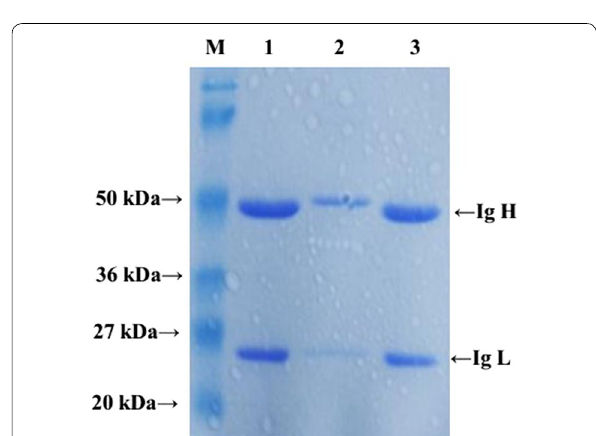
Fig. 2 SDS-PAGE analysis for ascites. Bands of 50 kDa and 25 kDa were identified as heavy and light chains. Lane M, protein molecular weight marker; lane 1, mouse ascites of 1D6; lane 2, mouse ascites of 2G6; lane 3, mouse ascites of